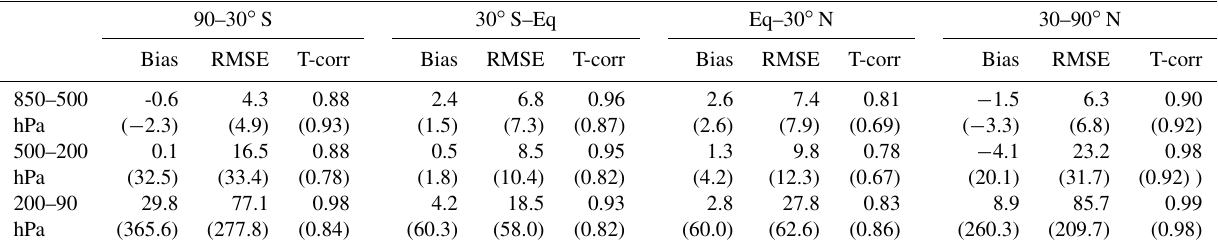
Figure 1. Comparison of vertical ozone profiles from ozonesondes (black), control run (blue), and reanalysis (red) averaged for the period 2005–2009. Top row shows mean profile; middle and bottom rows show mean difference and RMSE between control run and observations (blue) and between the reanalysis and the observations (red) relative to the mean ozonesonde concentrations (in %). From left to right, results are shown for SH extratropics (30–90 ◦ S), SH tropics (30 ◦ S–Eq), NH tropics (Eq–30 ◦ N), and NH extratropics (30–90 ◦ N). All ozonesonde observations taken from the WOUDC database were used in the comparison. Table 3. Chemical reanalysis (or control run in brackets) minus ozonesonde comparisons of mean ozone concentrations in 2005–2009. RMSE is the root-mean-square error. Units of bias and RMSE are ppb. T-corr is the temporal